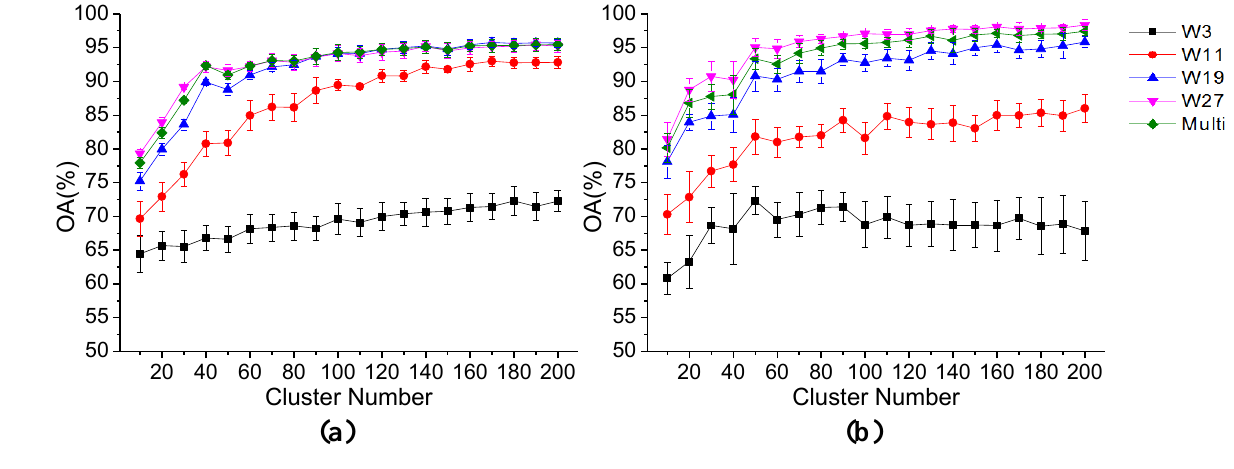
Figure 7. Classification accuracies of the proposed algorithm with different cluster numbers (40, 80, 120, 160, 200) for: ( a ) the Indian Pines image; and ( b ) the Pavia University image.